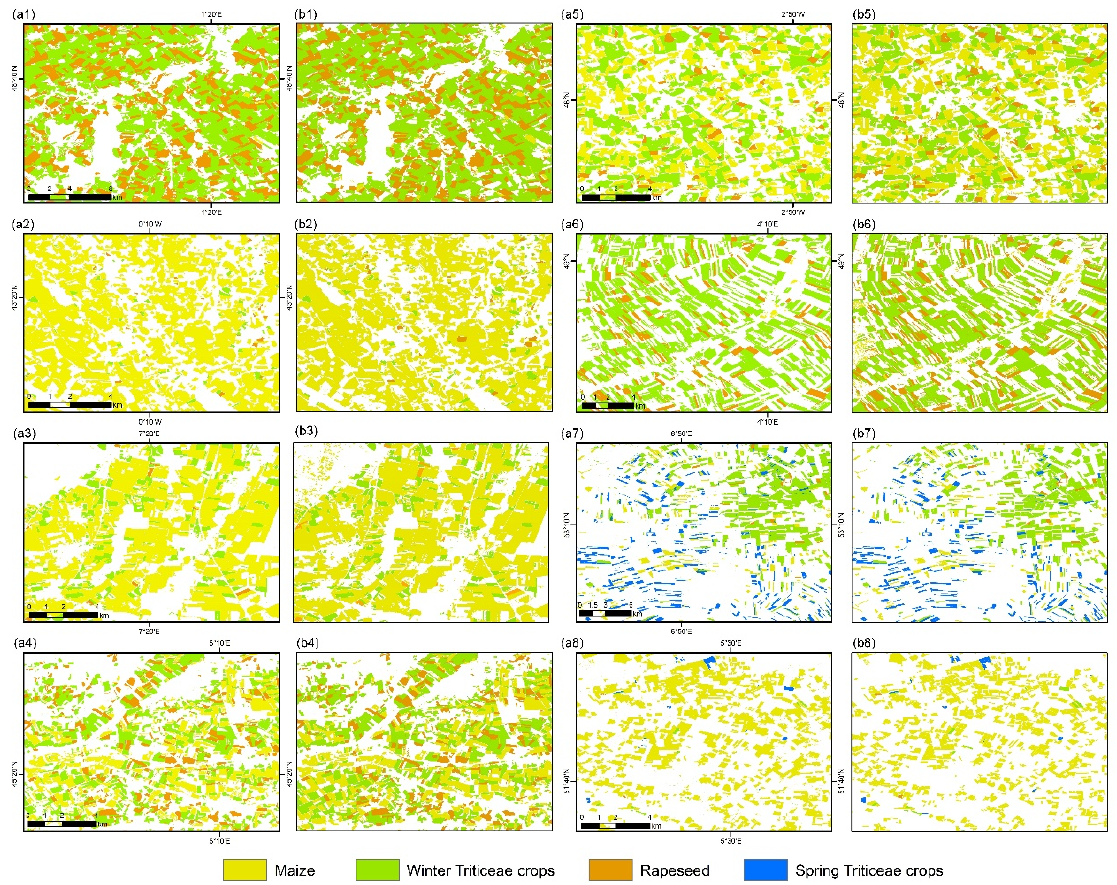
Figure 7. Visual comparison between ( a1 – a8 ) the resultant crop maps and existing reference datasets in 2019 for ( b1 – b6 ) France and ( b7 , b8 ) the Netherlands. For France, winter and spring Triticeae crops were grouped as a single category (green color).